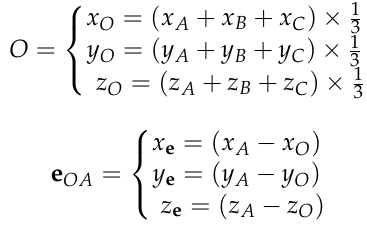
the vectors from the center point of the triangle to the vertices. vectors from the center point of the triangle to the